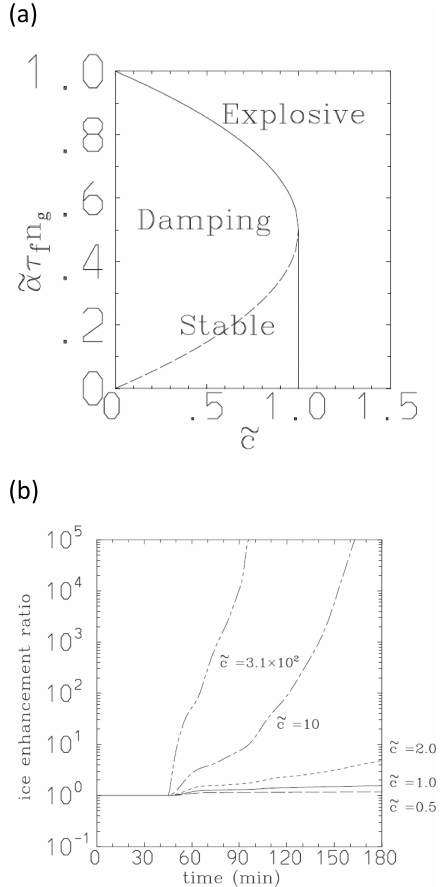
Figure 3. (a) The phase space of stability for the 0D model of ice– ice breakup for a population of ice crystals and small and large ice precipitation particles. The multiplication efficiency, ˜ c (proportional to the number of fragments per ice–ice collision), and dimensionless initial precipitation concentration are the two axes. In (b) , the time evolution of the ice enhancement is shown for various values of ˜ c. Source: Yano and Phillips